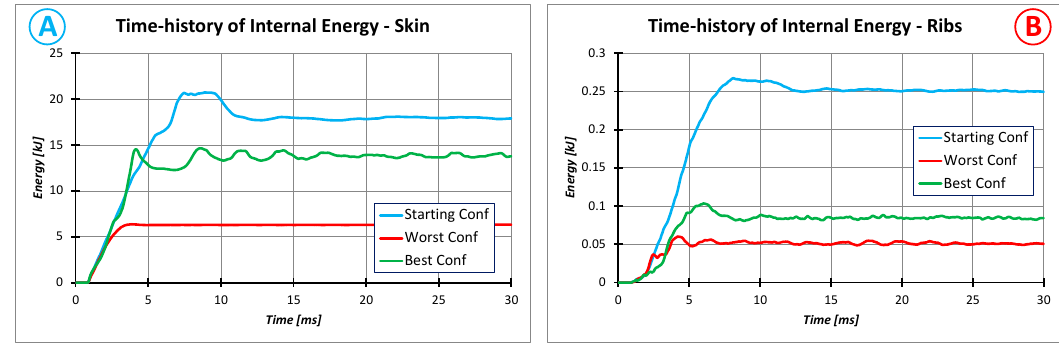
Figure 12. Time-history of internal energy for skin ( A ) and ribs ( B ).